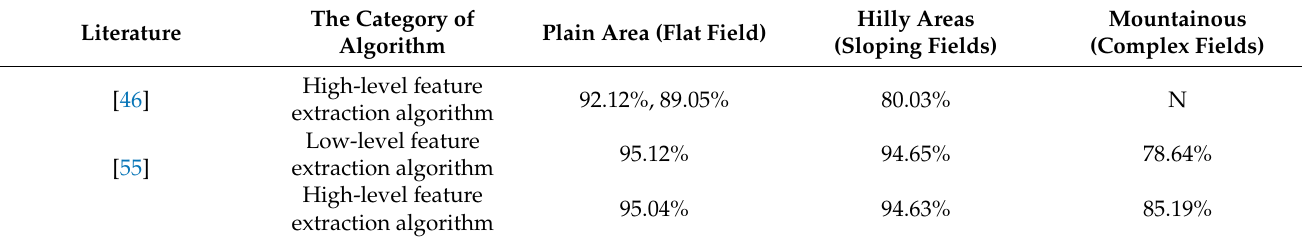
Table 16. Studies focusing on the flatness of the